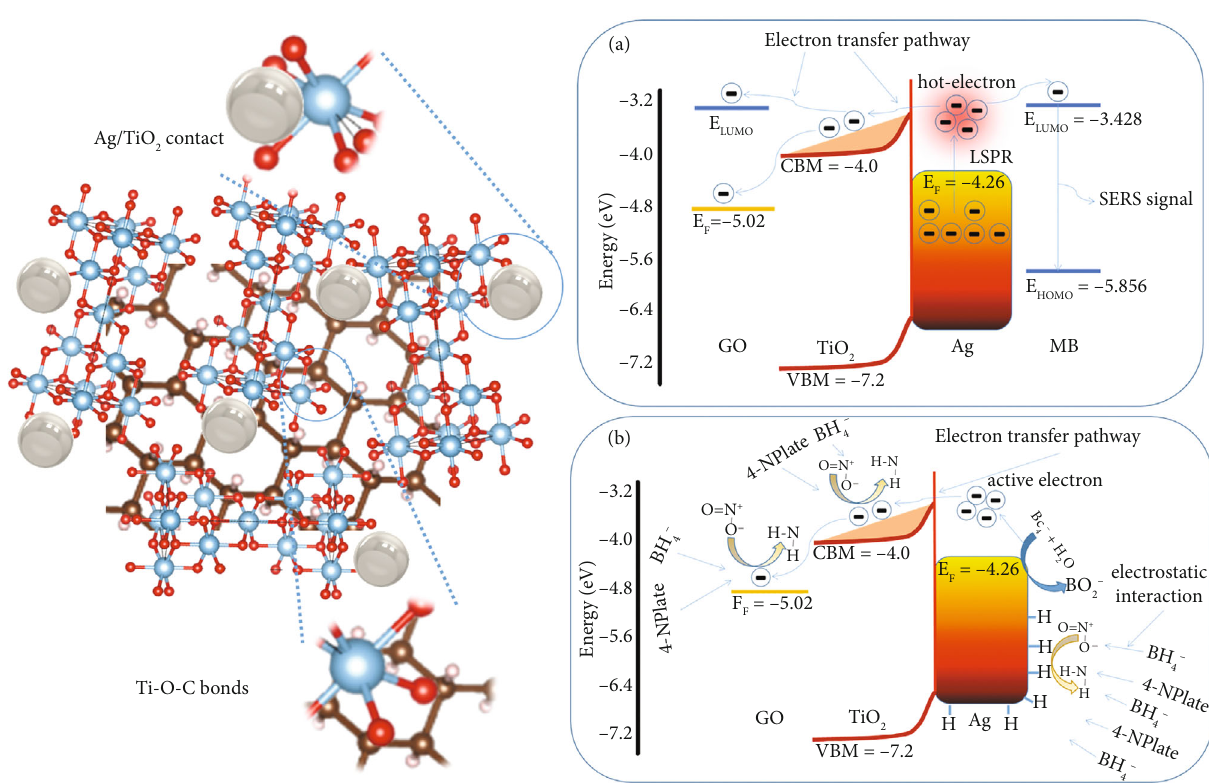
Figure 6: Potential electron transfer process in ATG Nces for both SERS sensor model (a) and catalytic reduction model (b) through contact and Ti-O-C bonds. Ag/TiO 2 Table 1: Several reported AgNP-based SERS sensors to determine MB and their sensing performance (LOD, EF; nanoparticles (NPs); graphene foam (GF); nanotube array (NTA; 4-mercaptobenzoic acid (4-MBA). Materials